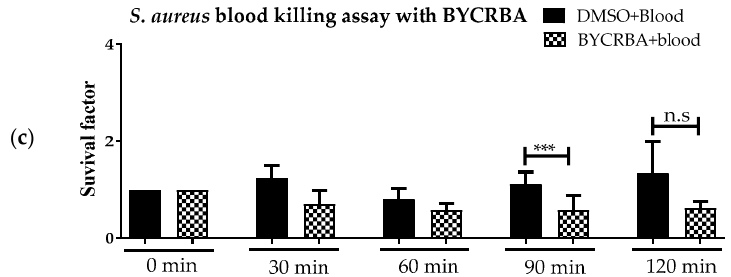
Figure 1. BYCRBA ( a ), MAVEVA ( b ), and VEOEBA ( c ) boost whole blood antimicrobial activity against S. aureus . Significant reduction of the bacterial count at time points 90 min and 120 min compared to non-treated cells was recorded after treatment of fresh human blood with the different plant extracts at a concentration of 10 μ g/mL. Depicted are the bacterial survival factors at defined time points in comparison to t = 0 from a minimum of n = 3 independent experiments. ** p ˂ 0.005, *** p < 0.001 one-tailed, paired Student’s t -test. Dimethyl sulfoxide (DMSO). In control experiments, S. aureus was co-incubated with the different plant extracts at 37 °C in the absence of blood (Figure 2). Staphylococcal growth was monitored by plating surviving bacteria on agar plates to enumerate bacterial numbers. Interestingly, the extracts themselves exhibited no significant direct antimicrobial impact on the bacteria (Figure 2). Only a slight effect on bacterial growth was visible with MAVEVA (Figure 2b).